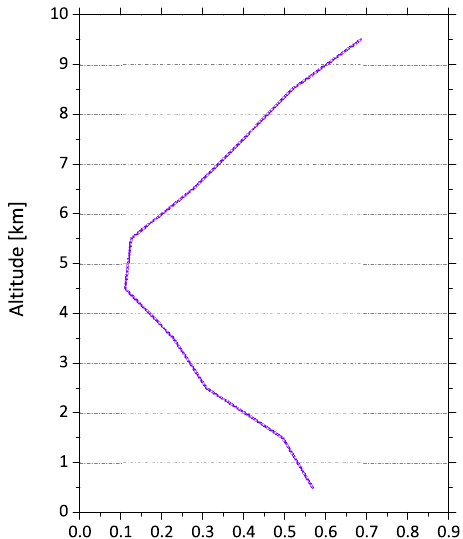
Fig. 4. Ratio of the square root of the diagonal elements of the smoothing error covariance matrix to the square root of the diag- onal elements of the a priori covariance